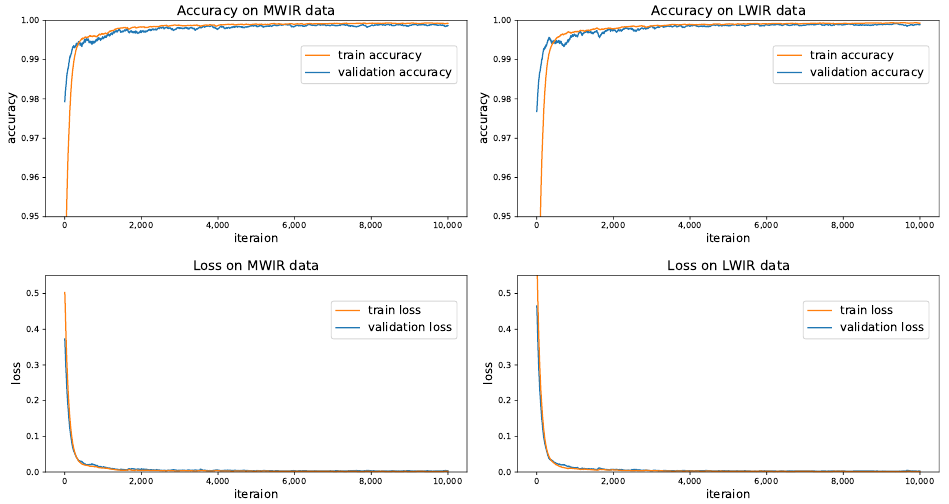
Figure 8. Learning curves during the training